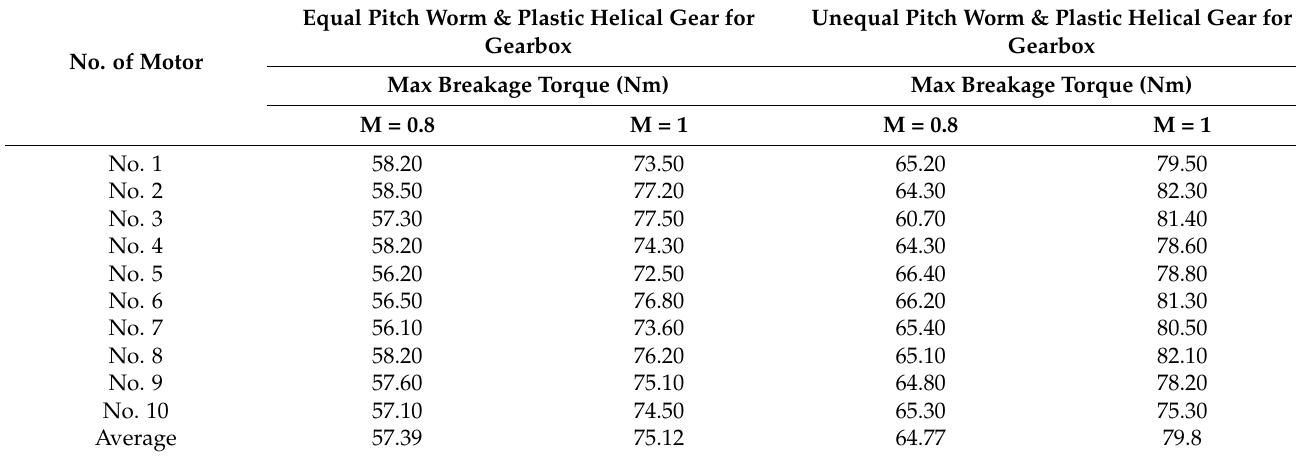
Table 6. Breakage test on the